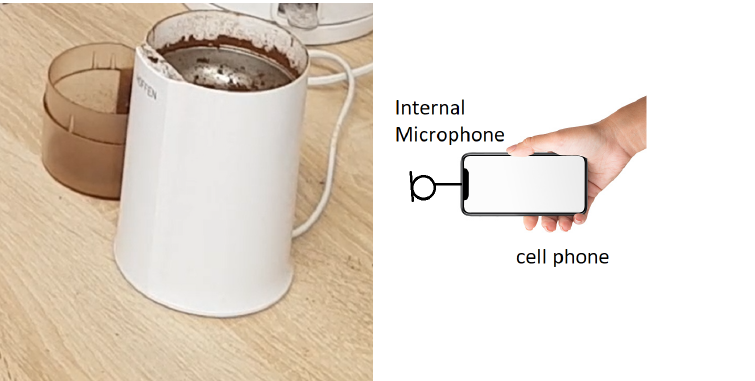
Figure 1. Acoustic signal measurements from coffee bean grinding using a mobile